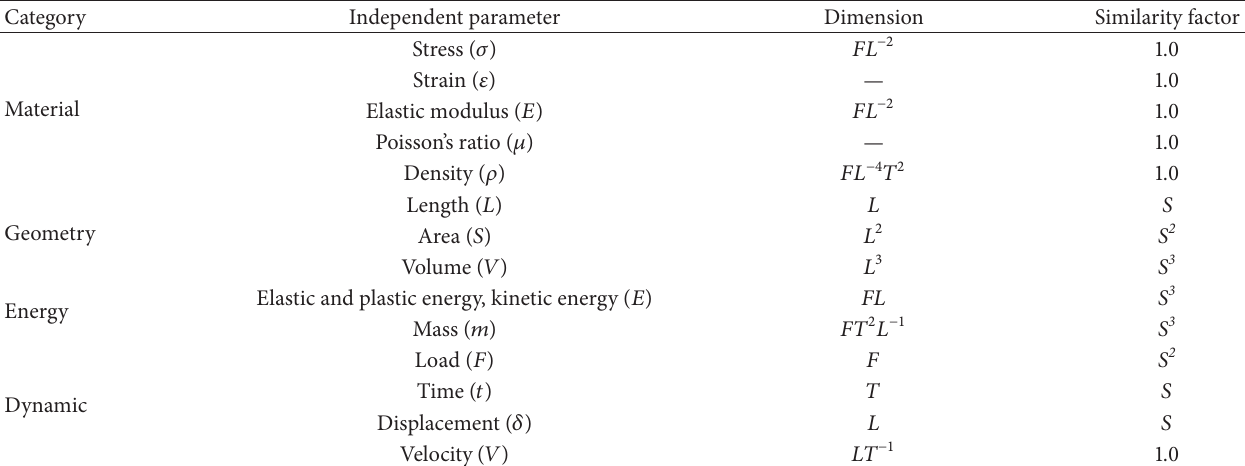
Table 1: Scaling parameters.